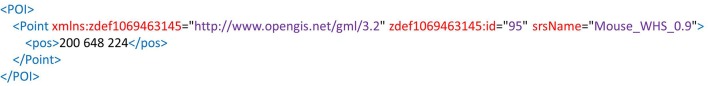
Representation of point of interest (POI) using the GML Point construct. Note that spatial reference system name is a mandatory attribute of Point.